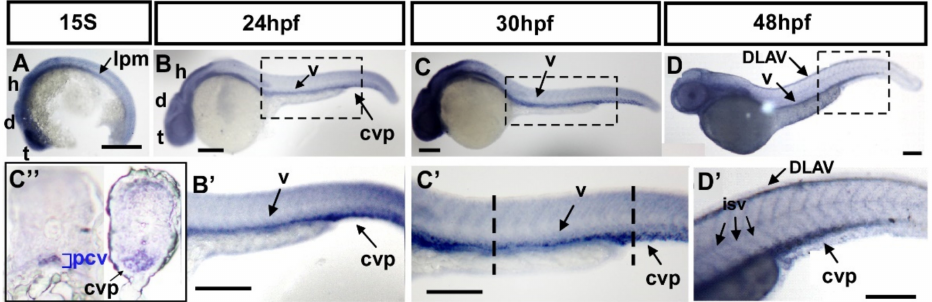
Figure 3. Expression pattern of fsta during zebrafish embryogenesis. ( A ) The expression of fsta is observed in the lateral plate mesoderm (lpm), the telencephalon (t), diencephalon (d), and hindbrain (h) at the 15S stage embryo. ( B , B (cid:48) ) At 24 hpf, fsta is expressed in the head, as well as in vessels (v), and caudal vein plexus (cvp) of the trunk. ( B (cid:48) ) is an enlargement of ( B ). ( C , C (cid:48) ) At 30 hpf, fsta expression continues in the head, vessels (v), and CVP of the trunk. ( C (cid:48) ) is an enlargement of ( C ). ( C” ) Cross sections of embryos from ( C (cid:48) ) show that fsta is expressed in the posterior cardinal vein (pcv), and CVP. ( D , D (cid:48) ) At 48 hpf, fsta expression in the head, vessels (v), DLAV, and CVP of the trunk. ( D (cid:48) ) is an enlargement of ( D ). Scale bars in all figures represent 200 µ